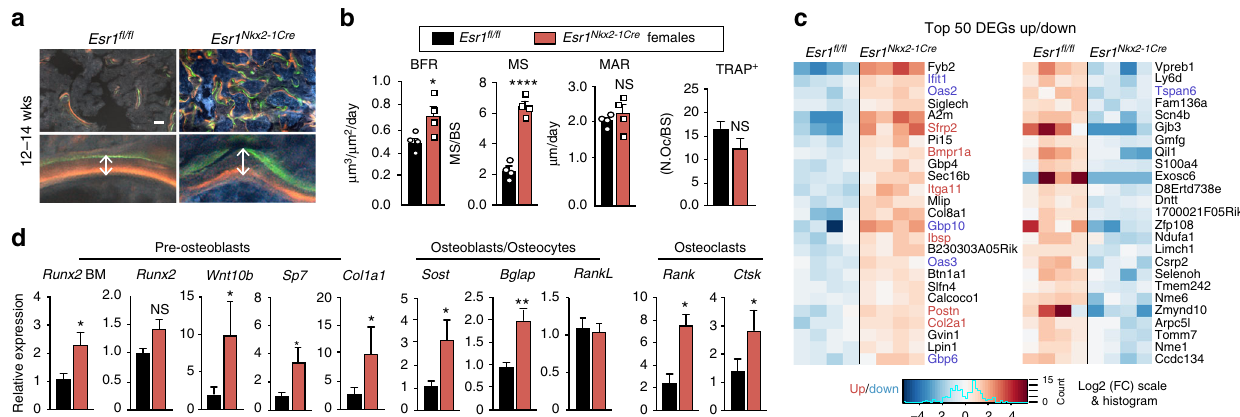
Fig. 3 Increased bone formation in Esr1 Nkx2-1Cre females. a Representative images of labeled mineralized surface of distal femur with calcein (green) and demeclocycline (orange) over a period of 1 week in a 12 week old female. Scale bars = 50 μ m. b Dynamic histomorphometric results for Esr1 fl / fl ( n = 4, black bars) and Esr1 Nkx2-1Cre ( n = 4, red bars) 12 – 14 week females showing bone formation rate (BFR), mineralized surface (MS), and mineralized apposition rate (MAR). Number of active osteoclasts normalized to bone surface quanti fi ed by TRAP-positive staining determined in distal femurs from 5- to 7-week-old Esr1 fl / fl ( n = 5) and Esr1 Nkx2-1Cre ( n = 6) females. c Heat map of top 50 differentially expressed genes (DEGs) up and down in 4.5-week-old Esr1 fl / fl and Esr1 Nkx2- 1Cre bone marrow Esr1 fl / fl ( n = 4) and Esr1 Nkx2-1Cre ( n = 4) females. BMP regulated genes (red) and IFN regulated genes (blue). d Quanti fi cation of indicated transcripts marking pre-osteoblasts, osteocytes, and osteoclasts in 4.5 – 7-week female control ( n = 10) and mutant ( n = 7) fl ushed bone marrow (BM), or in female control ( n = 13) and mutant ( n = 8) femur bone chips. Error bars are ±SEM. Unpaired Student ’ s t test ( b , d ). * p <0.05; **** p <0.0001. NS = p